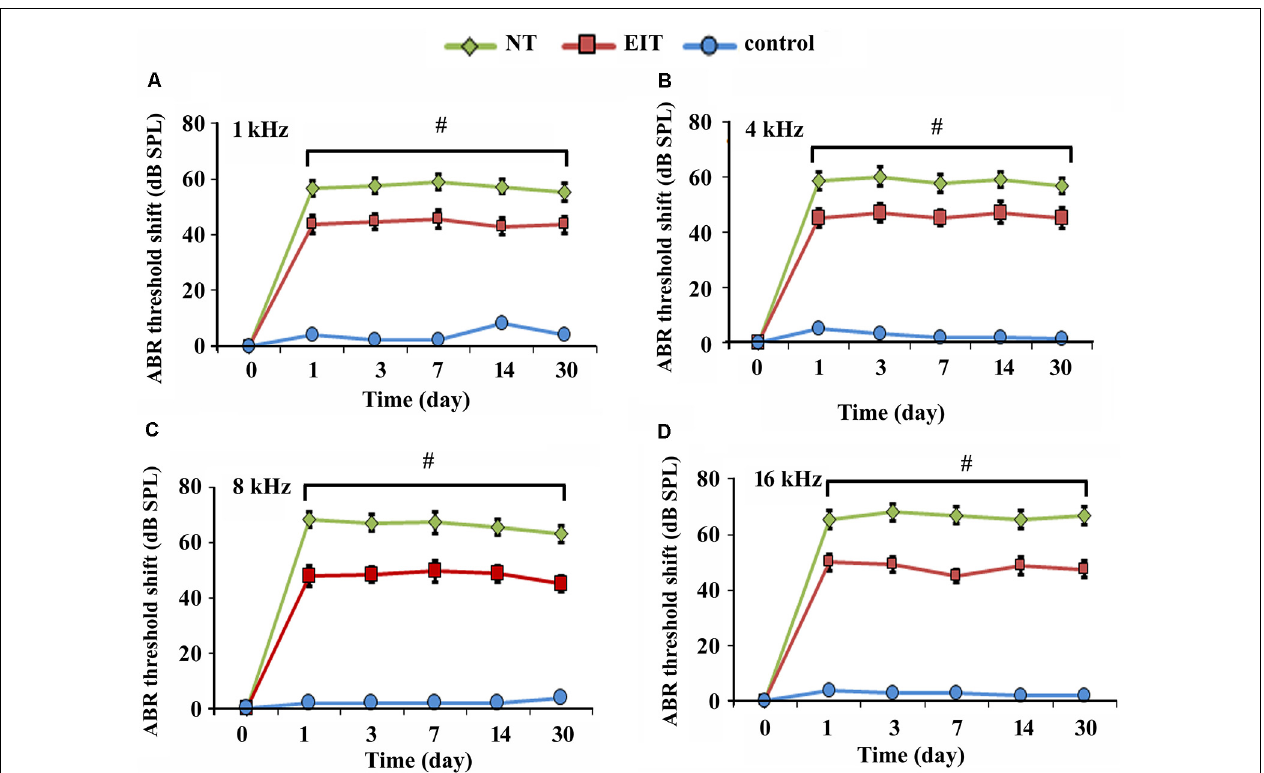
FIGURE 2 | Auditory brainstem recording (ABR) threshold shifts. Hearing threshold shifts in control, electrode insertion trauma (EIT) group, and animals exposed to noise trauma (NT) at 1 kHz (A) , 4 kHz (B) , 8 kHz (C) and 16 kHz (D) at different time-periods. ABR threshold shifts were significantly higher in NT groups compared to implanted animals. # P < 0.05 compared to the EIT group. Data represent mean ± standard